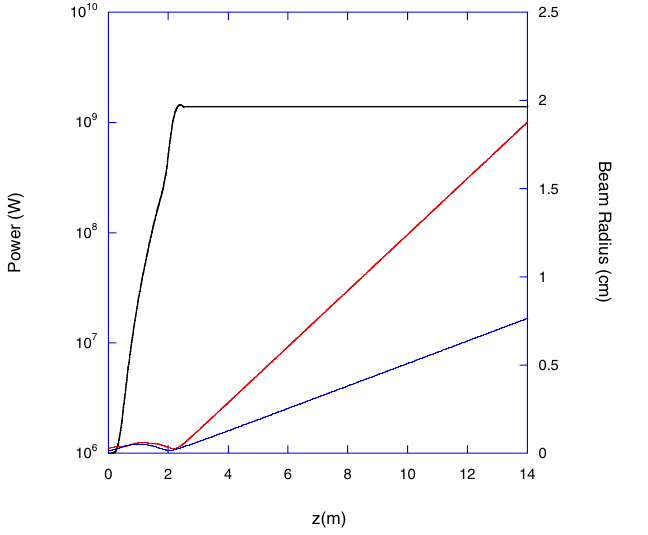
FIG. 8. (Color) Power (black), optical beam radius (red), and electron beam radius (blue) over a large distance for a scalloped- beam FEL with a two-stage wiggler.